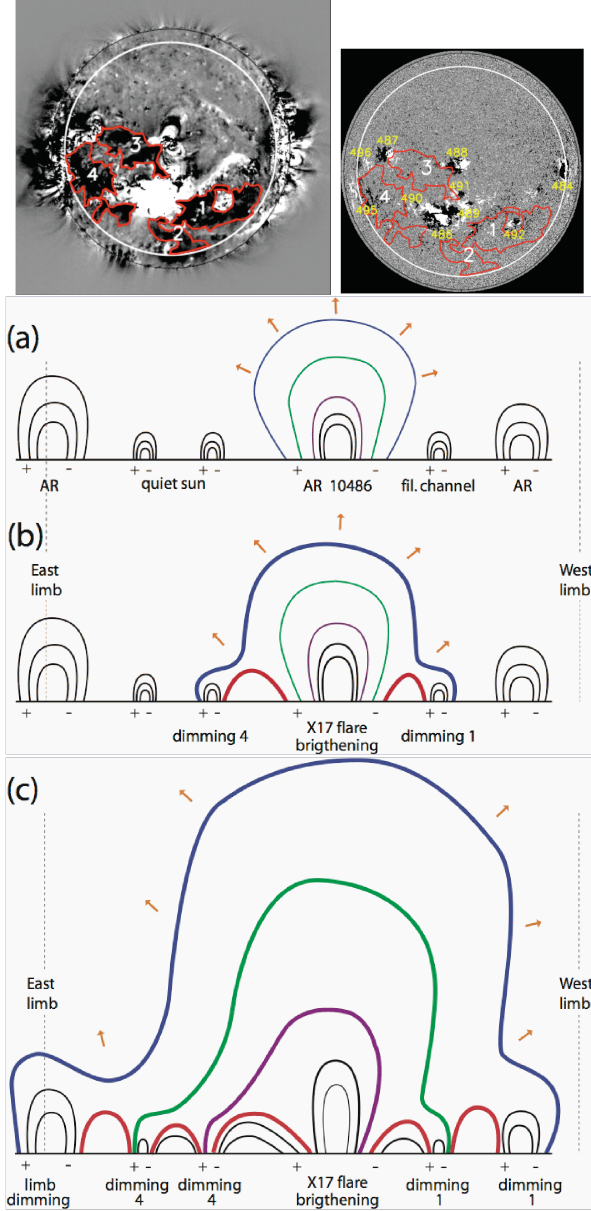
Fig. 12. A set of figures from Mandrini et al. (2007) on 28 Octo- ber 2003 CME event showing how the surrounding magnetic stuc- tures become constituents of the large-scale CME. The upper panel shows the location of the main dimming regions (left: difference EIT; right: MDI image – the red contours enclose the main dimming regions). The lower panel shows a series of cartoons (a–c) depicting the lower-coronal evolution of this CME. The cause of formation of a large number of coronal dimming regions is explained by the pro- gression of subsequent reconnections between the expanding CME and various magnetic structures including the magnetic carpet, ARs and a magnetic arcade straddling a